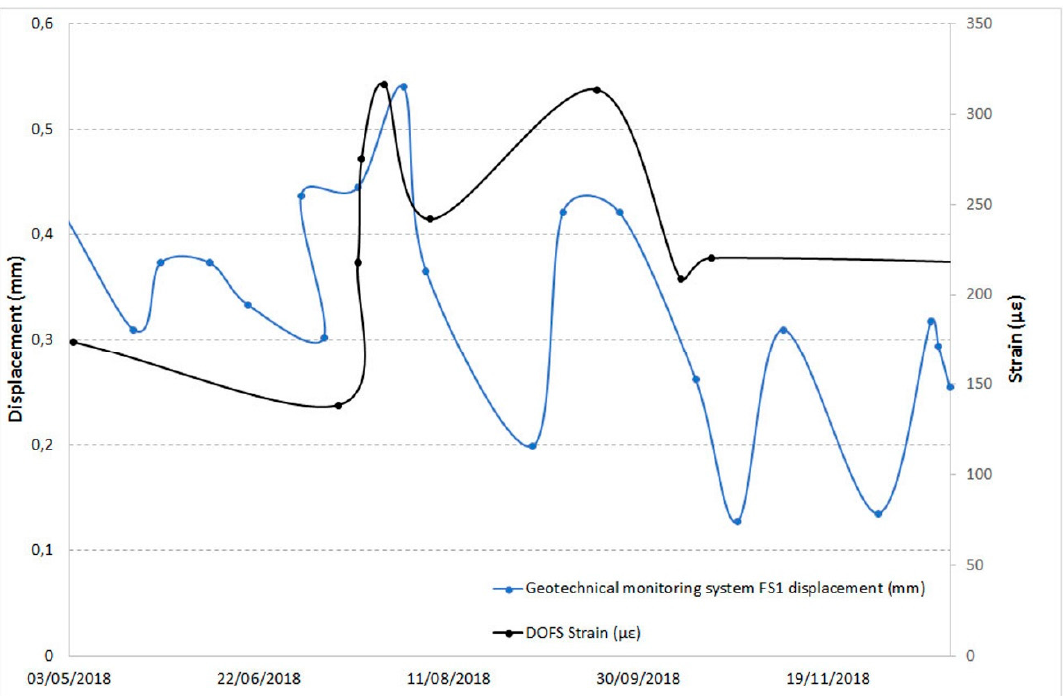
Figure 27. Comparison between the FS1 crackmeter displacements and DOFS strain values in the same area.